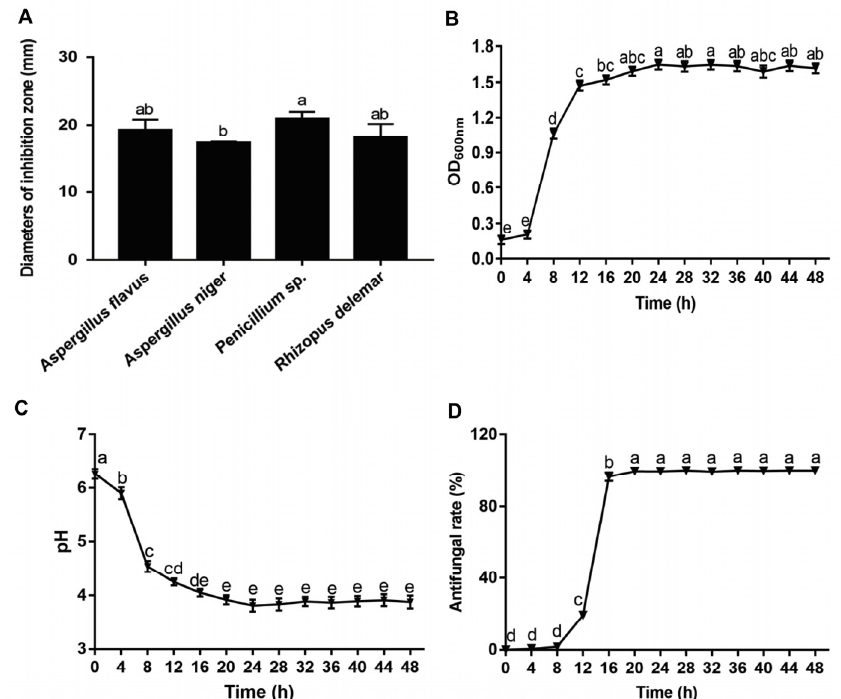
Figure 2. Antifungal activity of Lactiplantibacillus (Lpb.) plantarum LPP703 and its metabolites. ( A ) The inhibition effect of Lpb. plantarum LPP703 on Aspergillus flavus , Aspergillus niger , Penicillium sp., and Rhizopus delemar . ( B ) The growth curve of Lpb. plantarum LPP703. ( C ) The alteration in pH value during Lpb. plantarum LPP703 growth. ( D ) Inhibitory activity of Lpb. plantarum LPP703-produced metabolites against Penicillium sp. The one-way analysis of variance followed by Tukey’s test was used for statistical analysis. The different letters (a-e) denote significant differences ( p < 0.05).